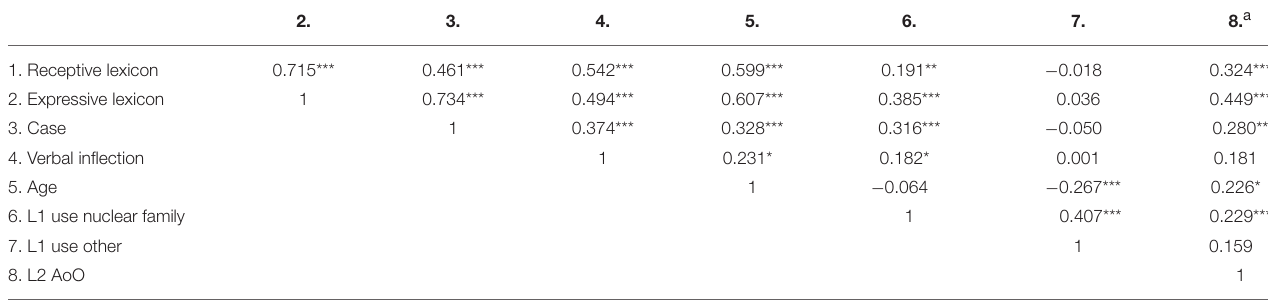
TABLE 3 | Correlations between language measures and background factors with Pearson correlation, a Spearman’s rank correlation, * p < 0.05; ** p < 0.01; *** p <